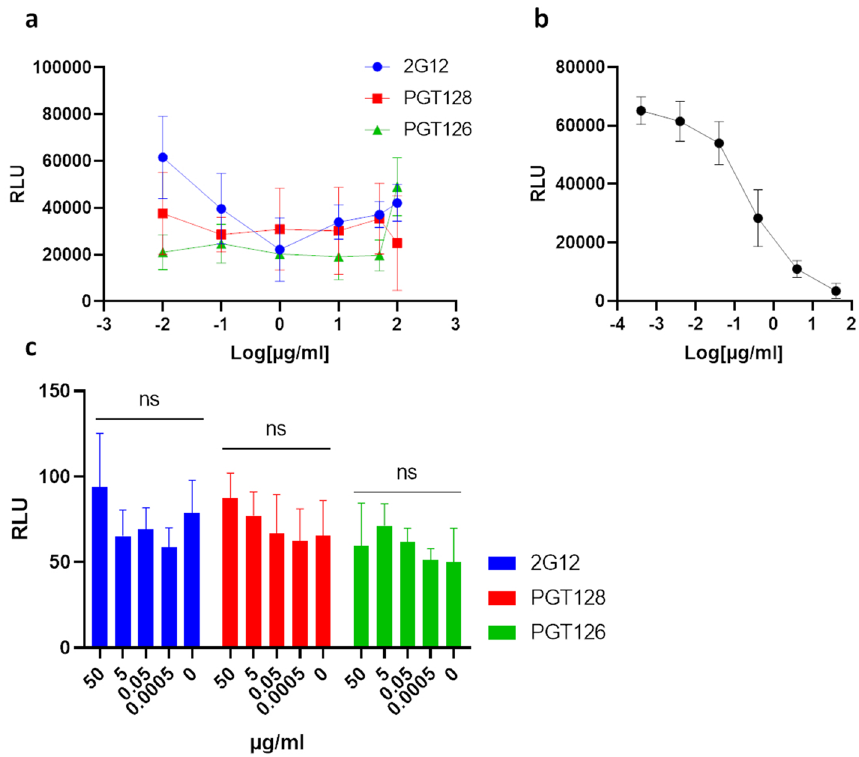
Figure 2. 2G12, PGT128 and PGT126 do not neutralize SARS-CoV-2 S pseudo-typed virus. ( a ) HEK293-T cells stably overexpressing ACE-2 were incubated with SARS-CoV-2 S pseudo-typed virus harbouring a luciferase reporter gene, in the presence of serial dilutions of the indicated anti-gp120 antibodies. Luciferase activities in cellular lysates were determined 48 h post-infection. (RLU: relative luciferase units). ( b ) Neutralizing antibody VH-FC ab8 subjected to the same assay described in ( a ). ( c ) Evaluation of antibody-dependent enhancement (ADE) for 2G12, PGT126 and PGT128 on the Fcγ RII expressing cell line: K562. SARS-CoV-2 S pseudo-type cell entry assays were performed on K562 cells as in ( a–c ). Experiments were done in triplicate; error bars indicate standard deviation (n = 3). Statistical significance was tested by two-way ANOVA